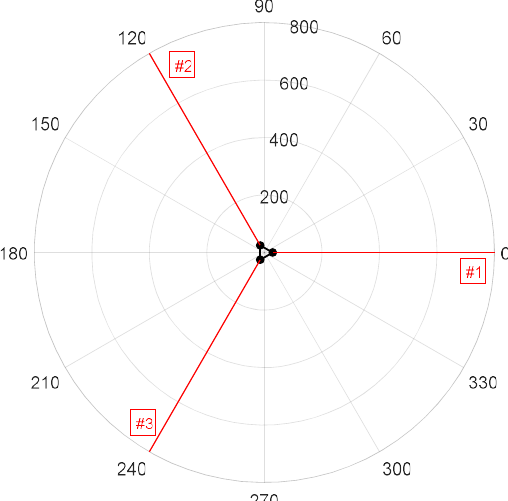
Figure 3. Layout of the reference stationkeeping system (the symbol # means line number).